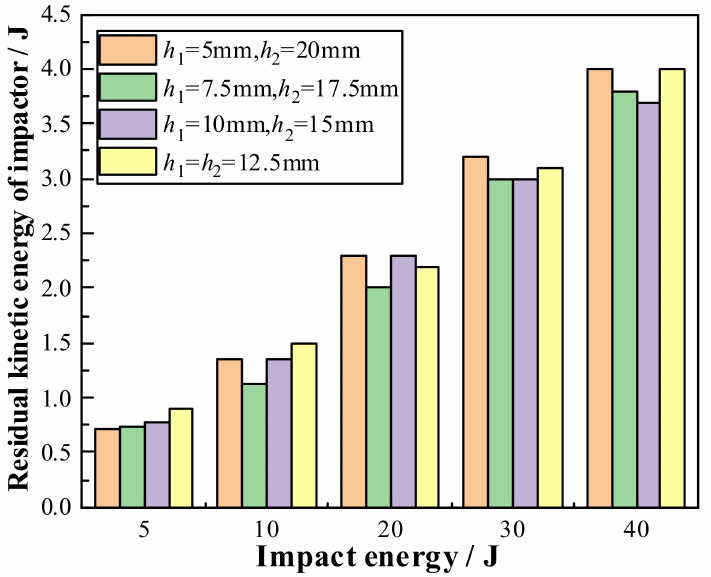
Figure 13. Residual kinetic energy of impactor of double − layer structures with different core heights after impact with different impact